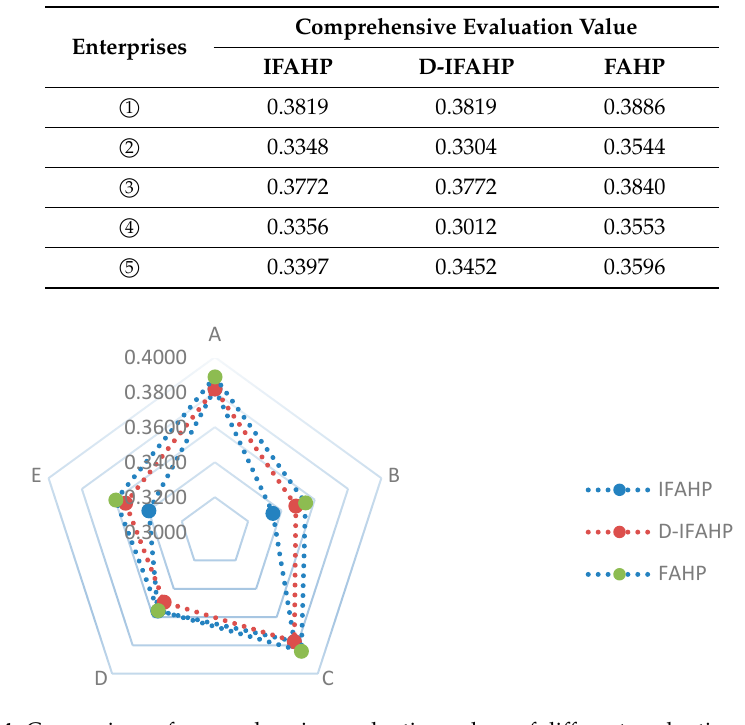
Figure 4. Comparison of comprehensive evaluation values of different evaluation methods.